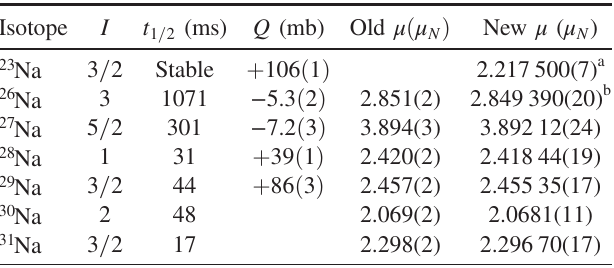
TABLE IV. Magnetic moments of 23 ; 26 − 31 Na determined in this work, compared to literature values [42,68], and other nuclear properties relevant for NMR.